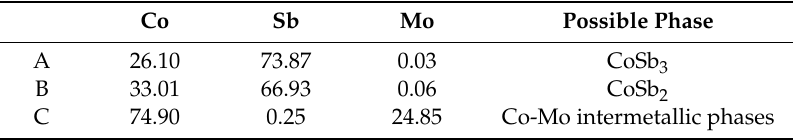
Table 1. Analysis of interface components (at %).